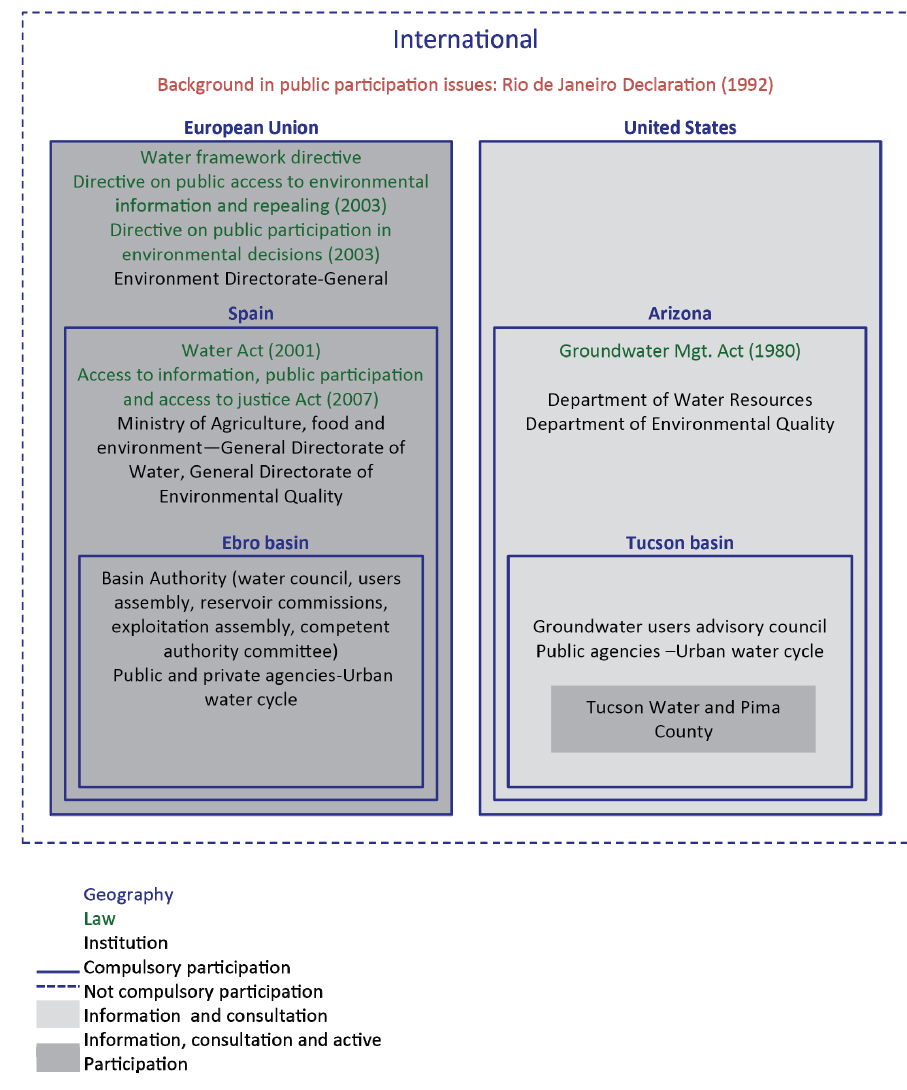
Figure 2. Legal and institutional frameworks for water management and public participation in Ebro and Tucson basins.